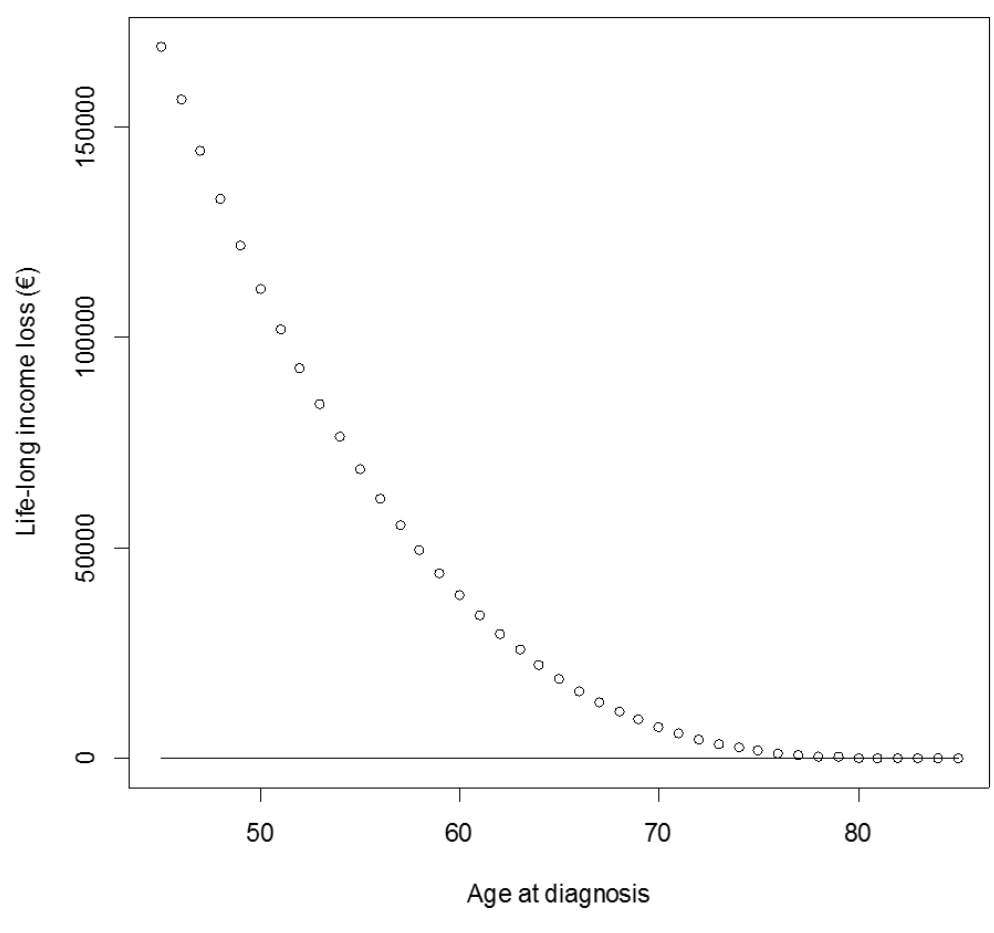
Figure 5: Extrapolation to higher age